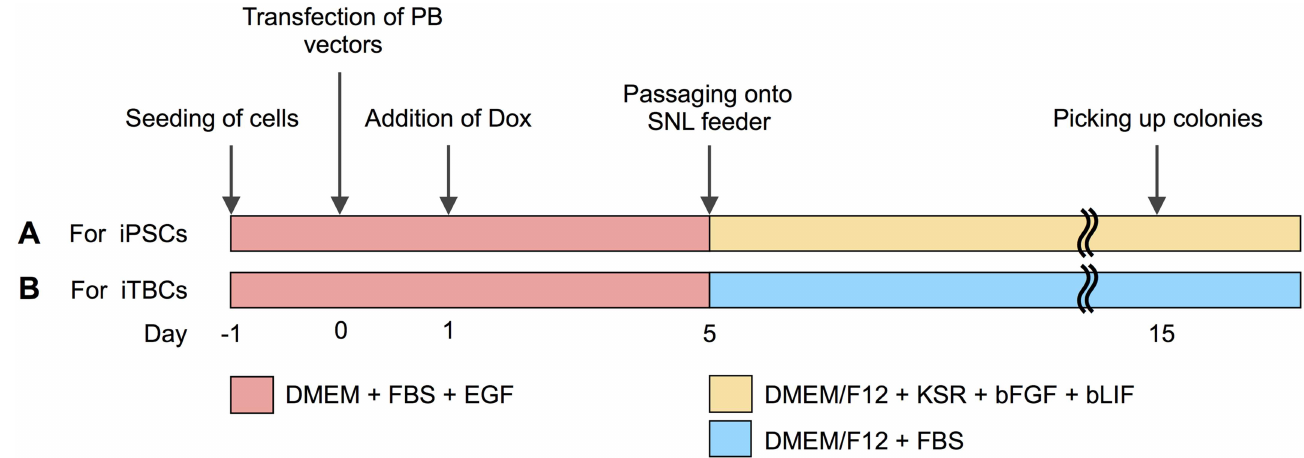
Fig 1. Generation of bovine-induced trophoblastic cells (biTBCs) using Dox-inducible PB vectors. (A) Timelinefor the establishment of biTBCs in culture medium used for humaniPSCs. (B) Timelinefor the establishment of biTBCs in culture medium used for bovine trophoblast cells (TBM).